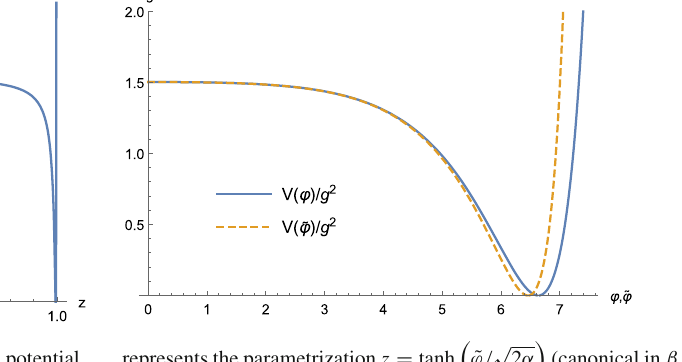
represents the parametrization z = tanh limit).Theparametersusedare α = 2, β = 10 − 3 ,and ω = 2 . 977 × 10 −